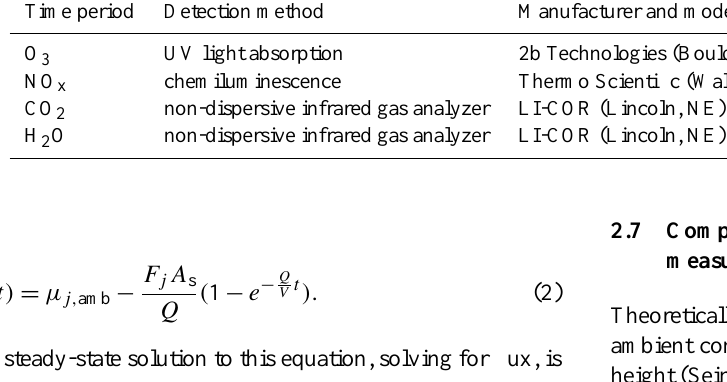
Table 2. Trace gas detectors used in this study, with manufacturers’ specifications. Time